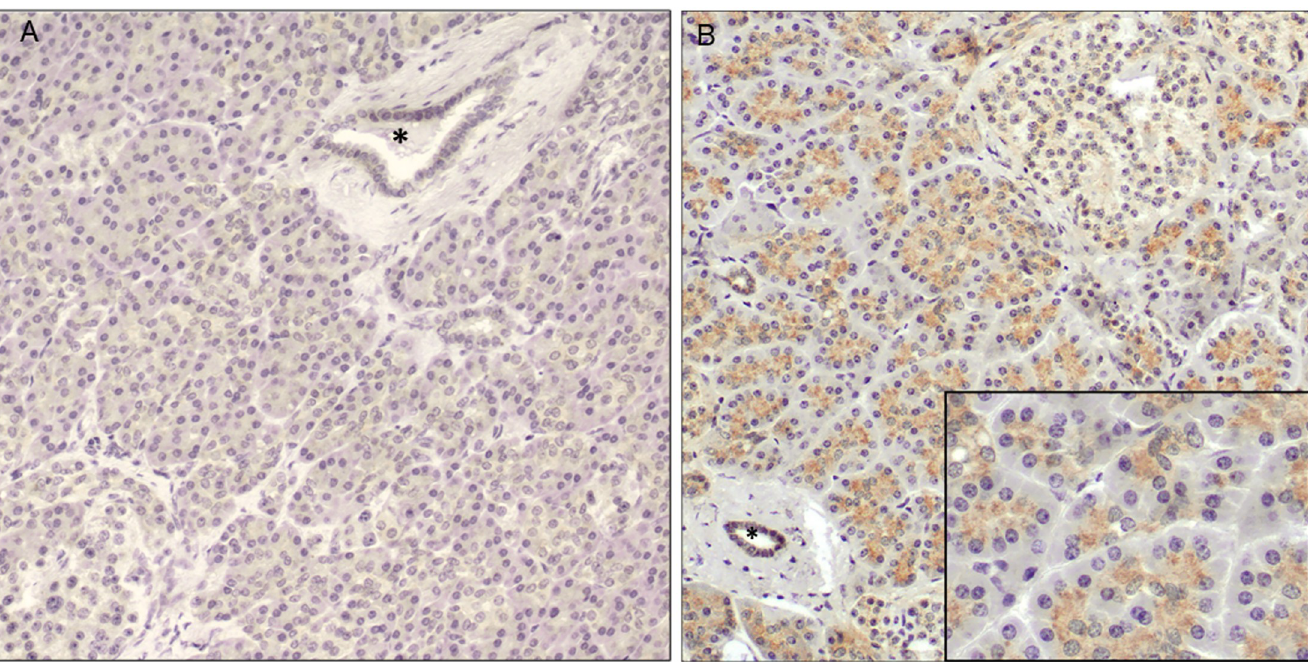
Fig 1. RNLS labeling in normal human pancreas. Representative images of RNLS labeling detected by immunohistochemistry using the m28-RNLS antibody in the normal human pancreas from (A) a patient who had undergone Whipple procedure for duodenal adenoma with essentially no signal and (B) a patient who had undergone splenectomy for trauma, showing granular cytoplasmic staining in acinar cells. The asterisk indicates a normal pancreatic duct. Original magnification 200x; inset 400x.